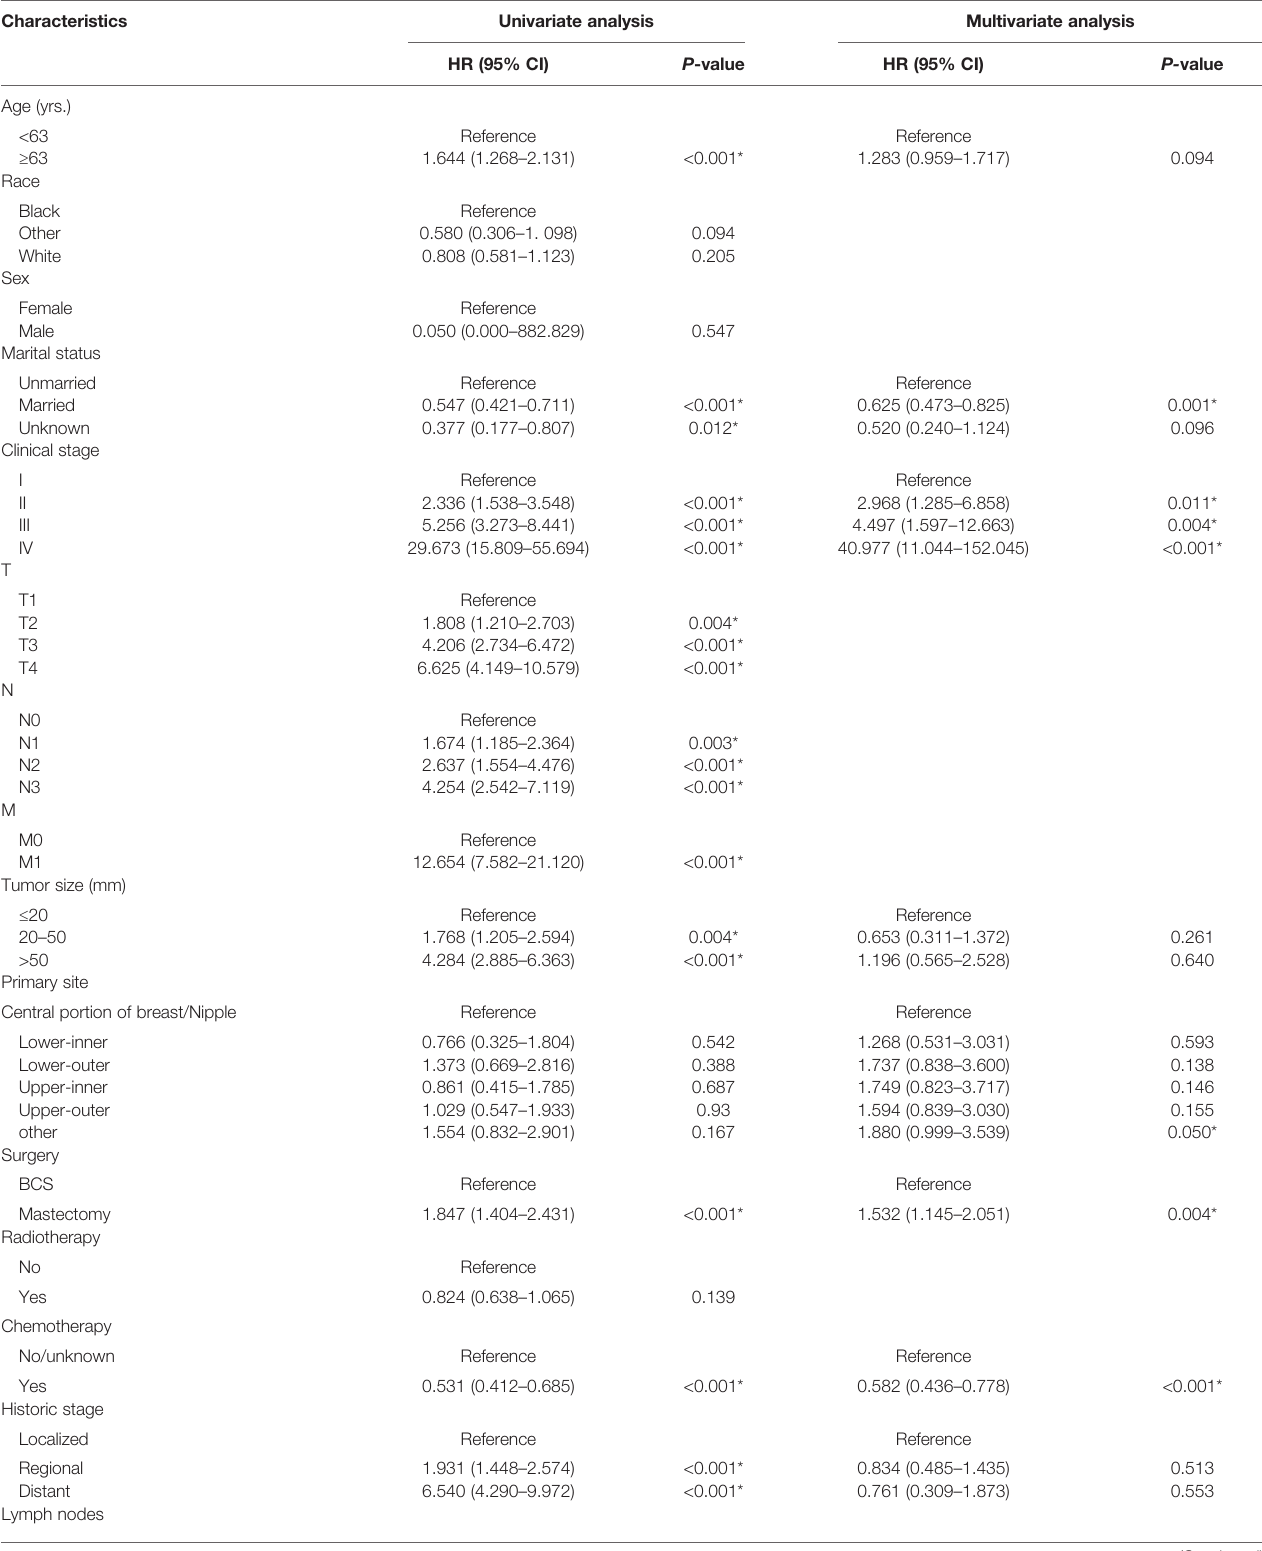
TABLE 2 | Univariate and multifactorial Cox analysis of risk factors in TN MpBC patients after surgery.